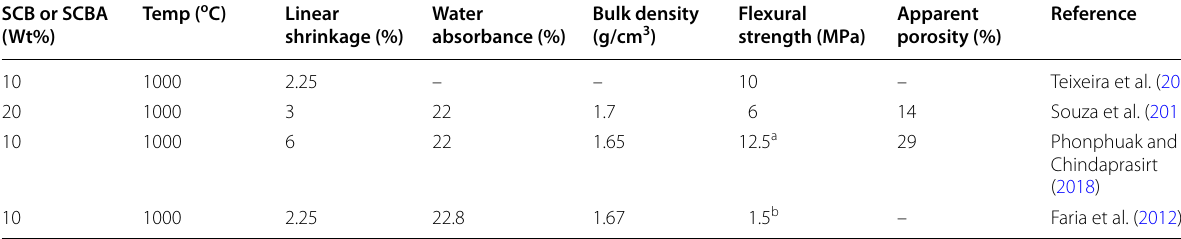
a Compressive strength, b tensile strength